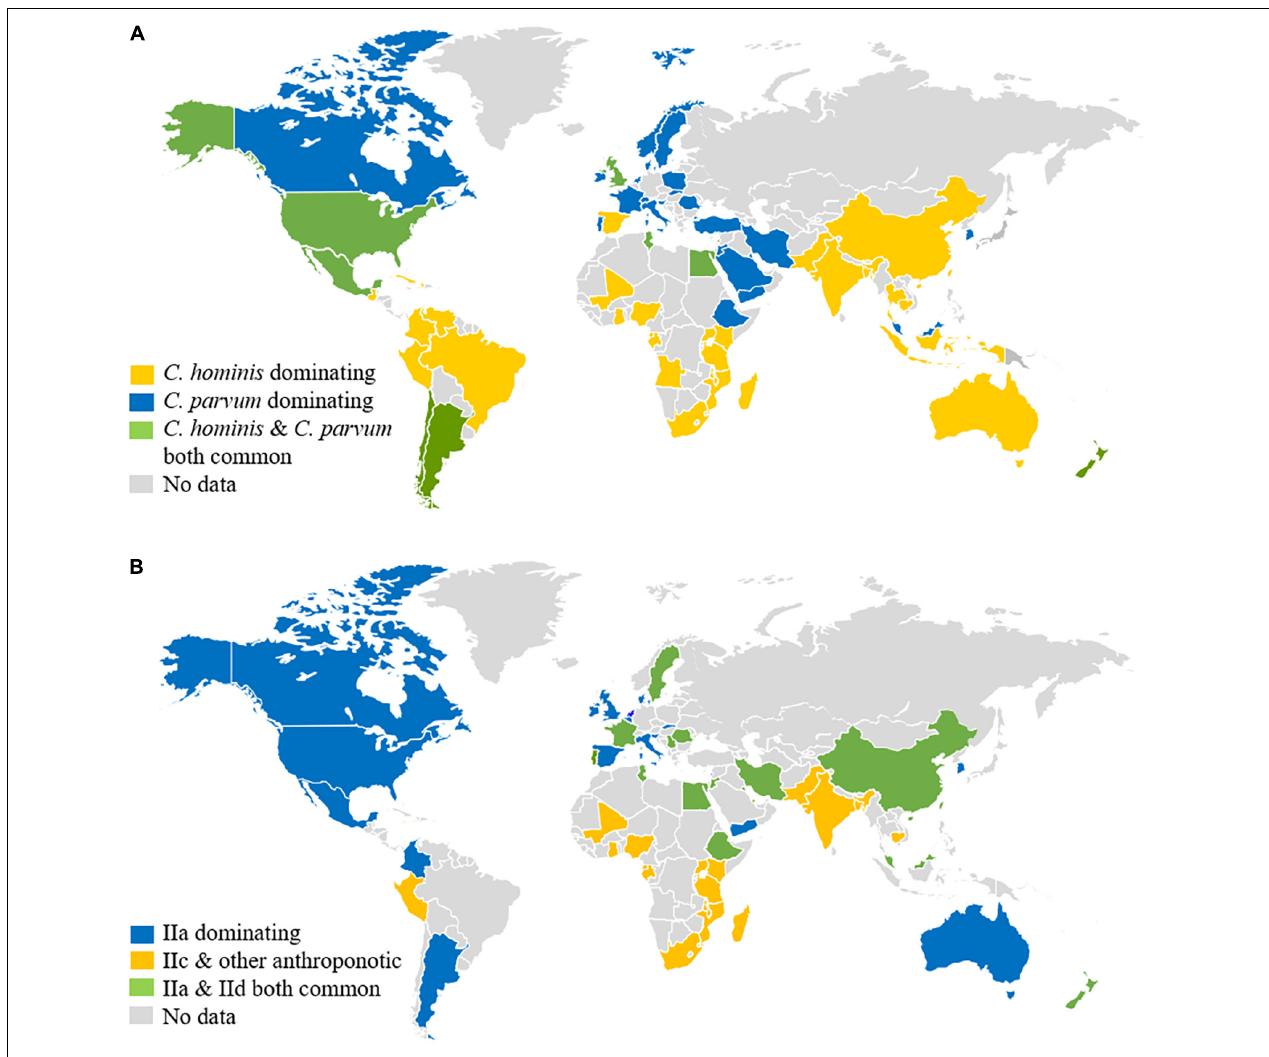
FIGURE 2 | Distribution of major Cryptosporidium species (A) and Cryptosporidium parvum subtypes (B) in humans around the world. Original data are presented in Supplementary Tables 1, 2 and a recent review (Yang et al.,